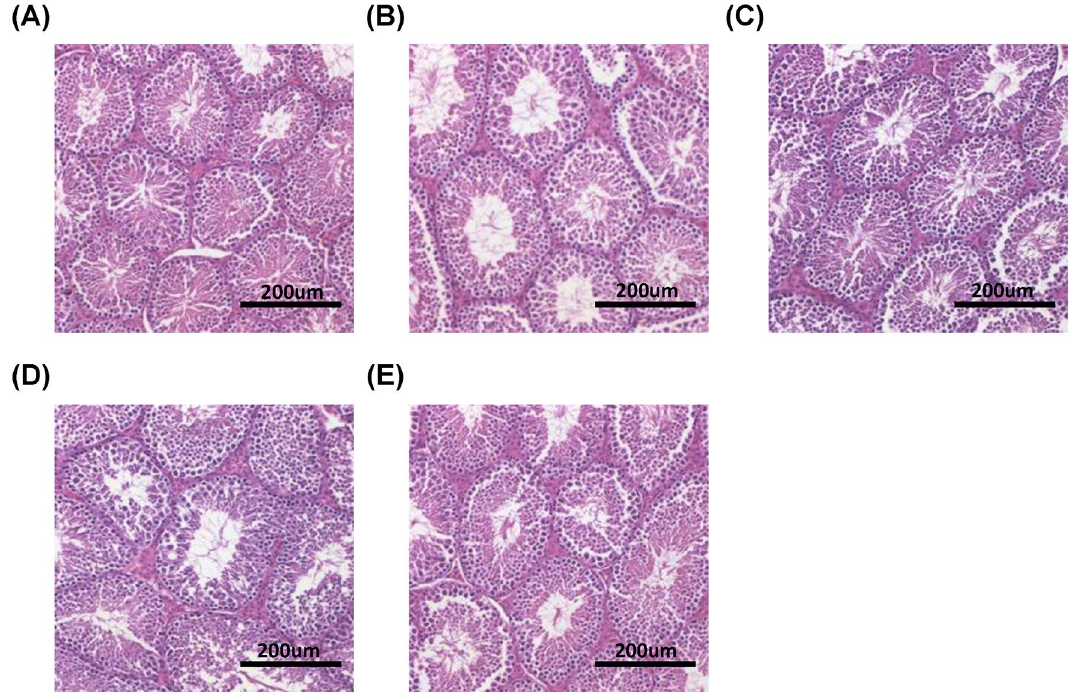
Figure 3. Effects of C. militaris fermentation products on testicular morphology and structure. Testicular sections of the CT group (A) , EPS group (B) , FB group (C) , MY group (D) , and FBMY group (E) were stained with H&E. Scale bars: 200 μm. Panels marked with different lowercase letters are significantly different ( p < 0.05).